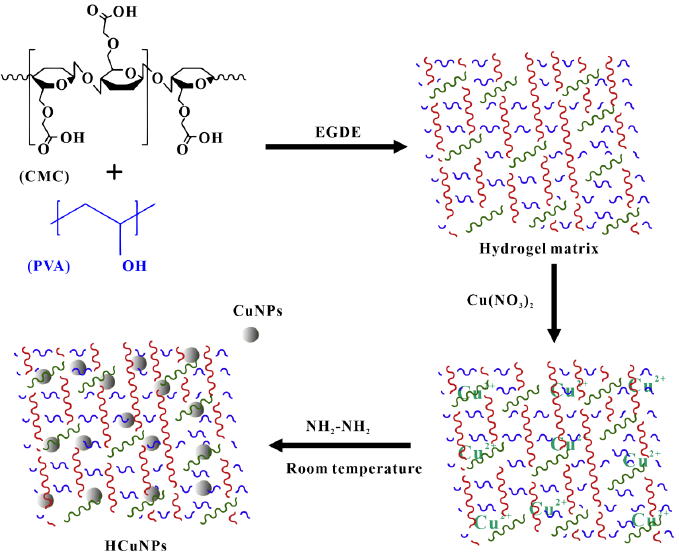
Figure 2. Schematic diagram of the preparation of CuNPs-cellulose hydrogel (reprinted from reference [78] with permission from Elsevier).